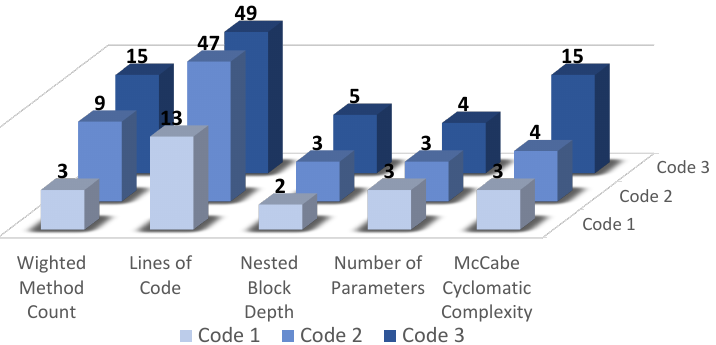
Figure 2. Complexity level of each code tasks according to each one of the five software complexity metrics used.